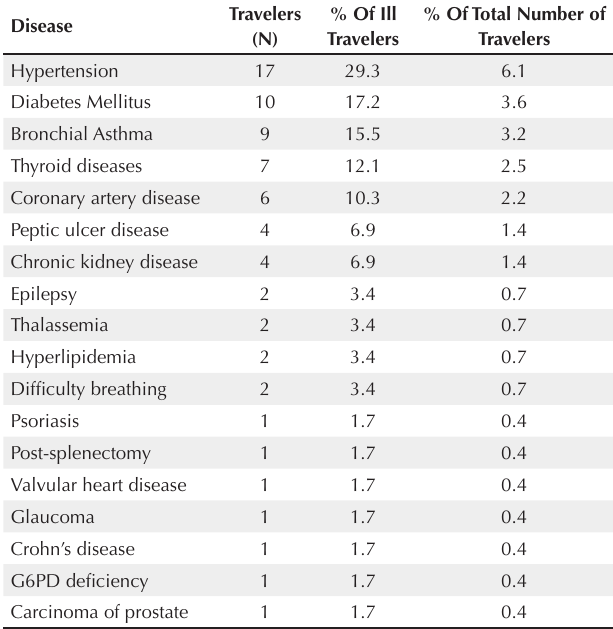
Table 3. Chronic Medical Conditions Among International Travelers From Qatar